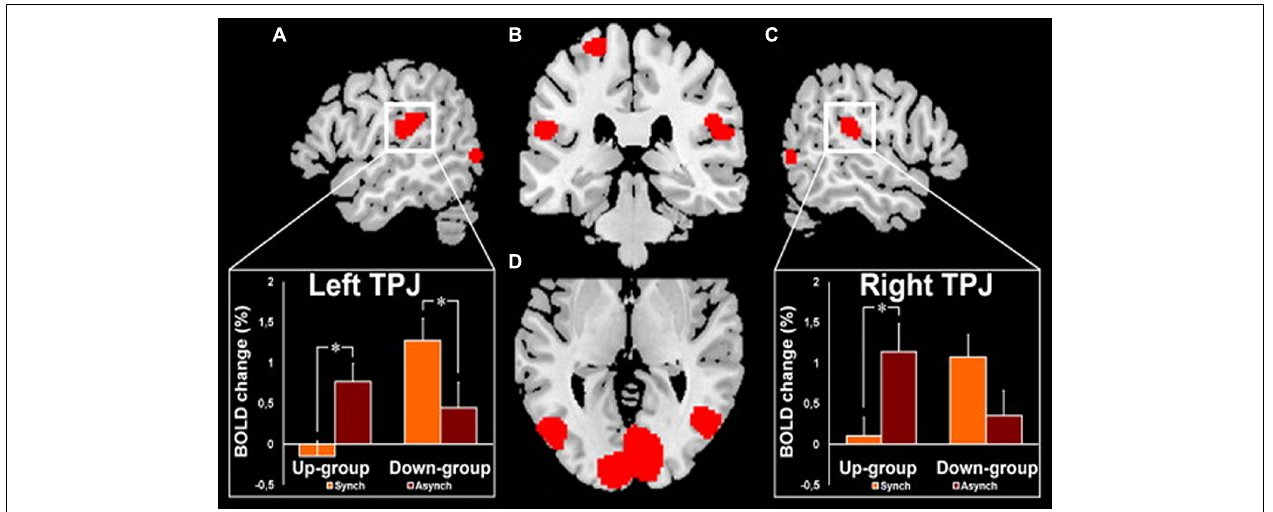
FIGURE 7 | fMRI activation in the right and left temporo-parietal junctions (TPJ) in healthy subjects during experimentally induced out of body experience (OBE). In the Up-group, the subjects experience themselves to look upward at a visually presented body and to be spatially higher with the synchronous as compared to the asynchronous strocking of their back. In the Down-group, the opposite pattern of sensations is observed as the subjects experience themselves to look downward and to be spatially higher with the asynchronous as compared to the synchronous strocking of their back.The magnitude of the blood- oxygenation-level-dependent (BOLD)